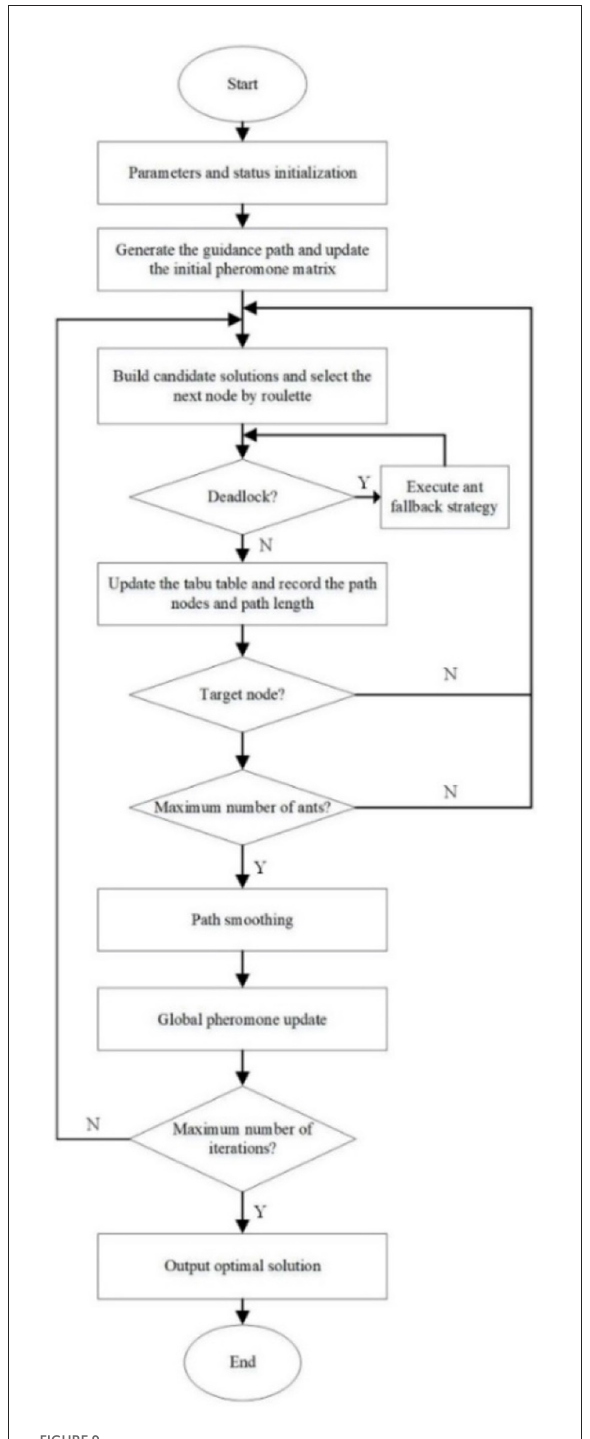
FIGURE9 Flow chart of improved ant colony optimization